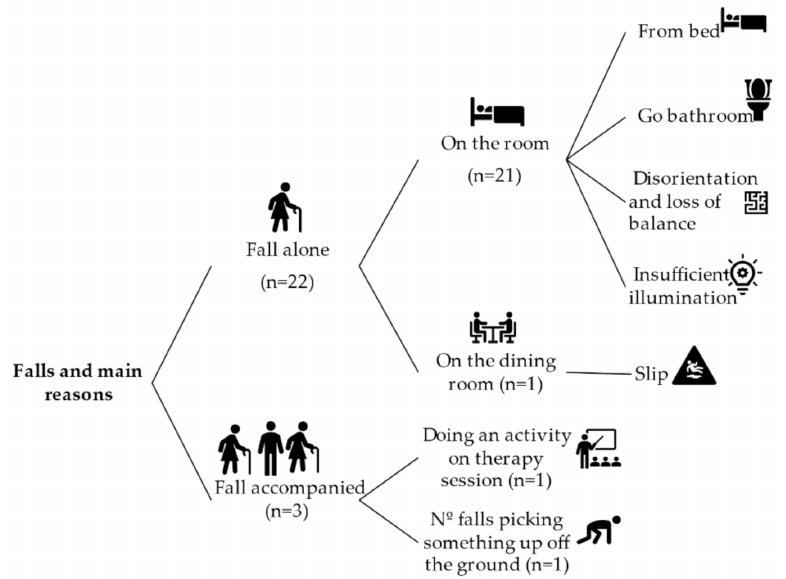
Figure 1. Fall distribution and main causes.